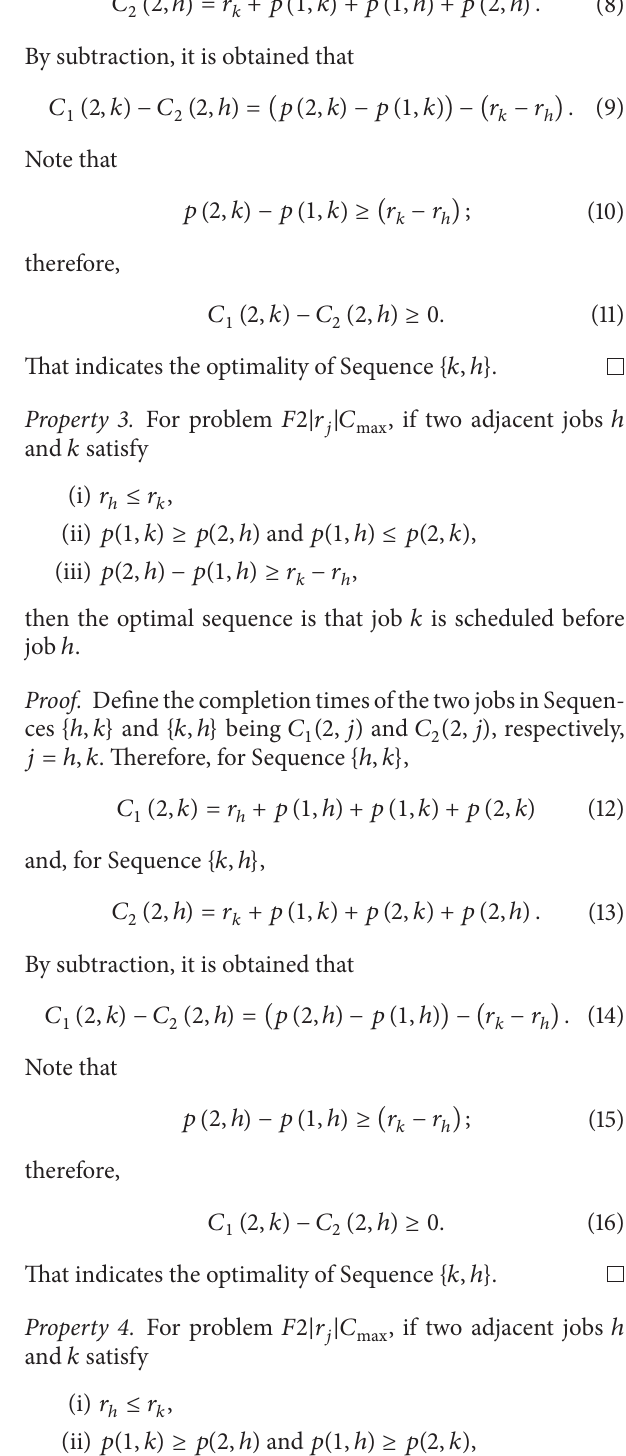
makespan problem with release dates are presented as fol-